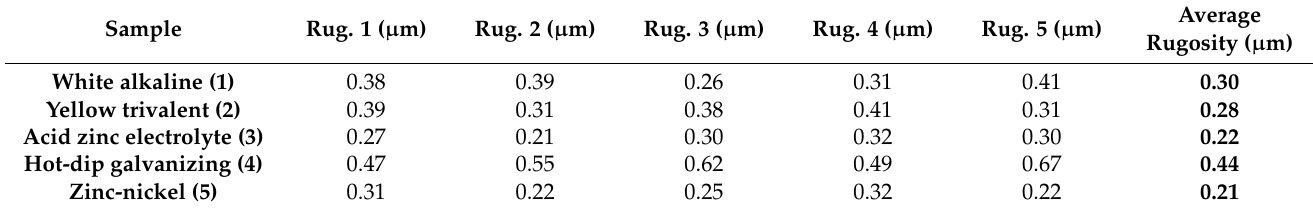
Table 3. Superficial rugosity of the